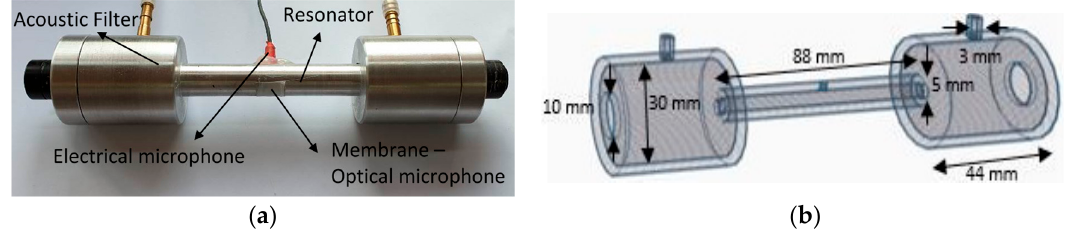
Figure 1. Resonant gas cell (RGC). ( a ) Metal resonant gas cell. ( b ) Structure and dimensions of the resonant gas cell (in mm).